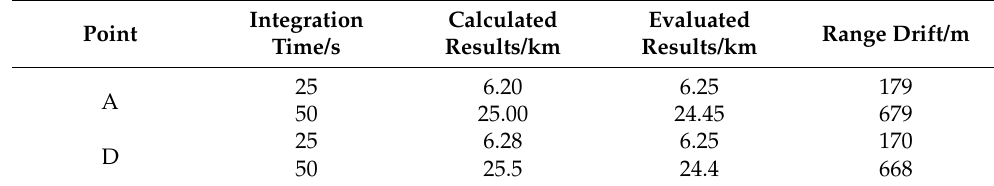
Table 4. Length and drift of the interference zone in range-direction for different points and integra- tion time.